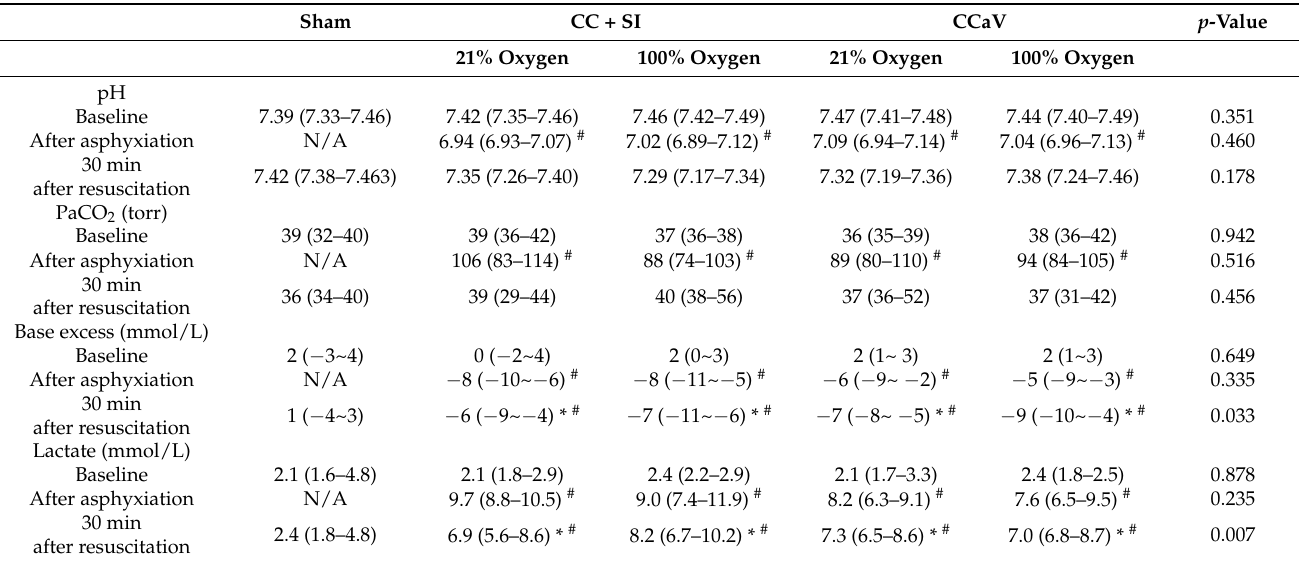
Table 3. Blood gas changes before and after